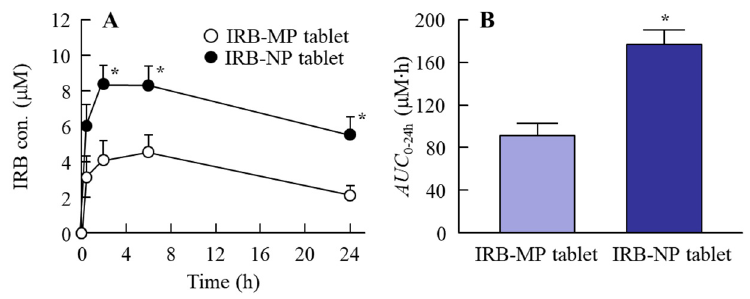
Figure 7. ( A ) The absorption profile and ( B ) AUC 0–24 h of IRB in the rats orally administered the IRB- MP and IRB-NP tablets (Rp.8). IRB-MP tablet, IRB-MP tablet-administered rats. IRB-NP tablet, IRB- NP tablet-administered rats. n = 6–7. * p < 0.05 vs. IRB-MP tablet for each category. The intestinal